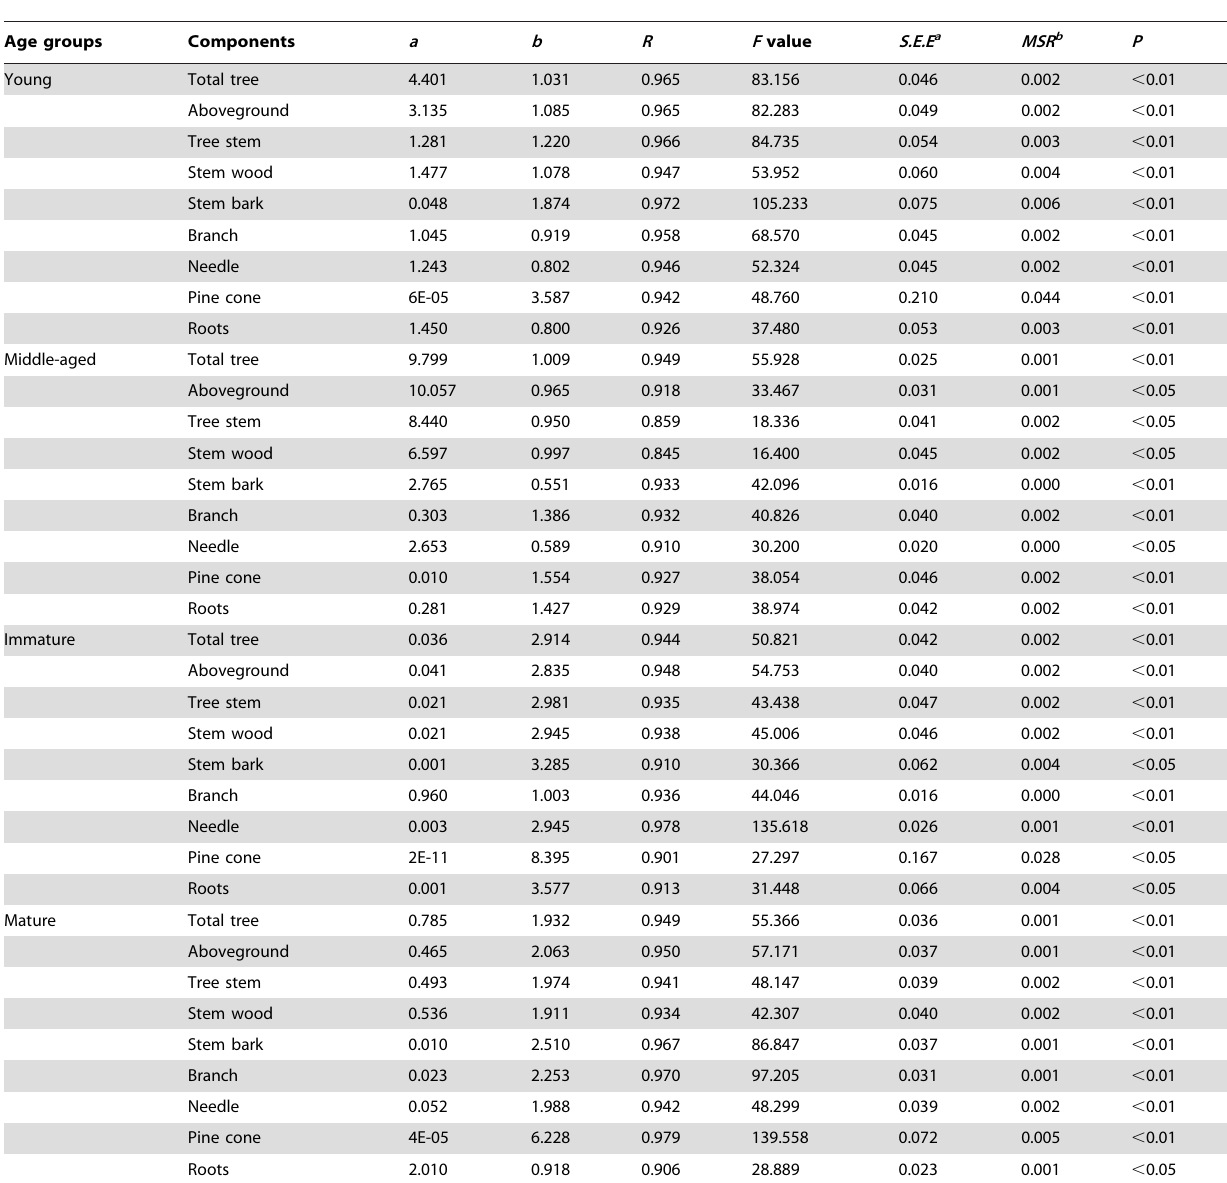
Table 2. Parameters and statistics of biomass equations for different tree components in P. tabulaeformis forests.